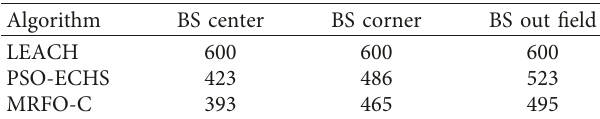
Figure 17: Total energy consumption for 500-node network, 50 CHs when the BS is at the outside the ROI. Table 3: Total energy consumption (in Joules) at round 5000 for 300-node network and 30 CHs.